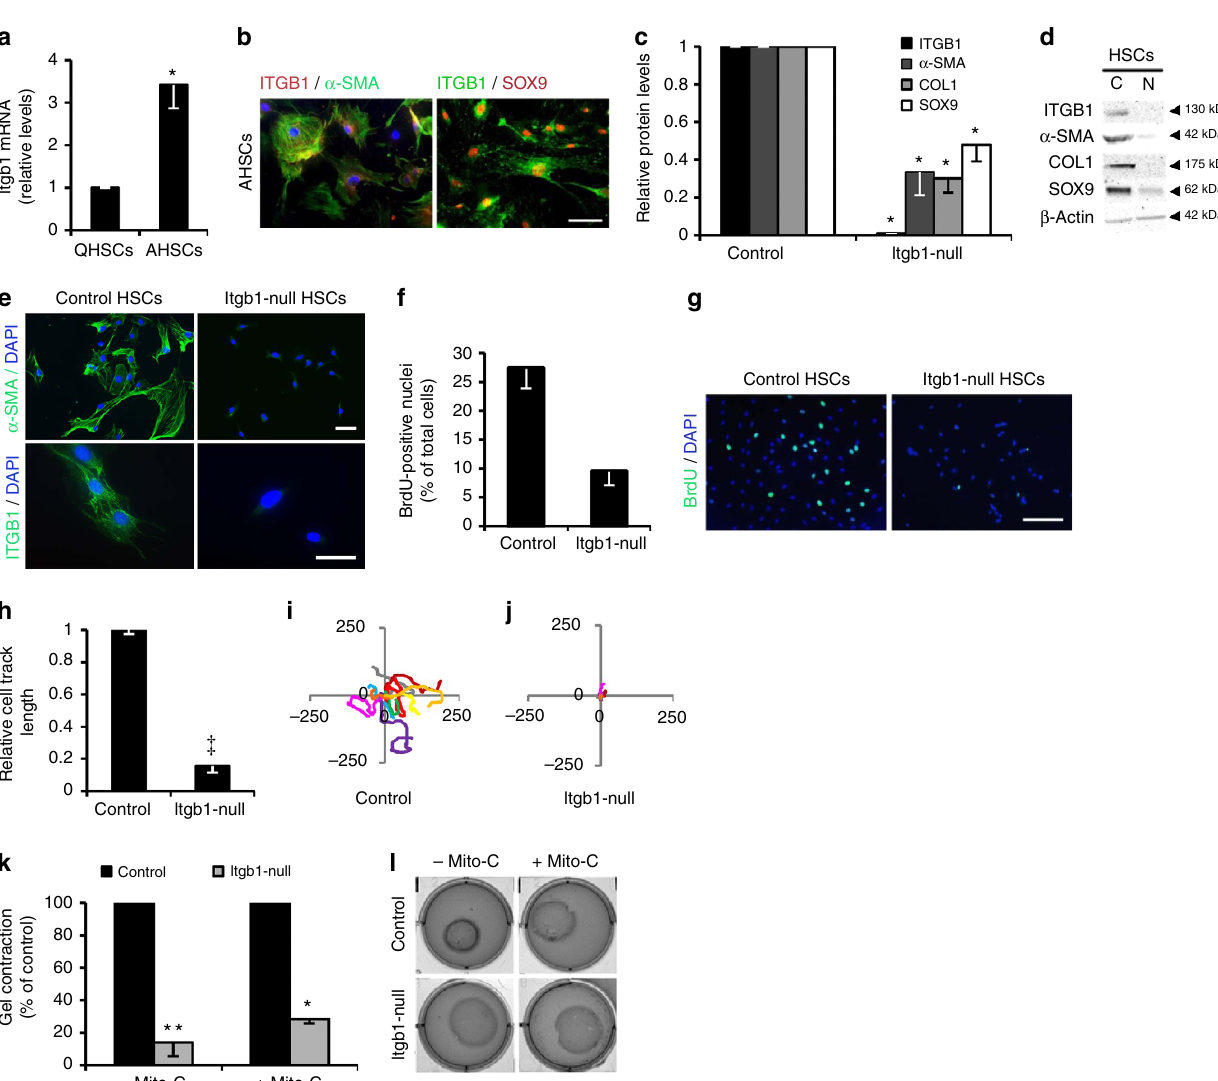
mechanosensitive transcriptional coactivator, YAP-1 (ref. 23);